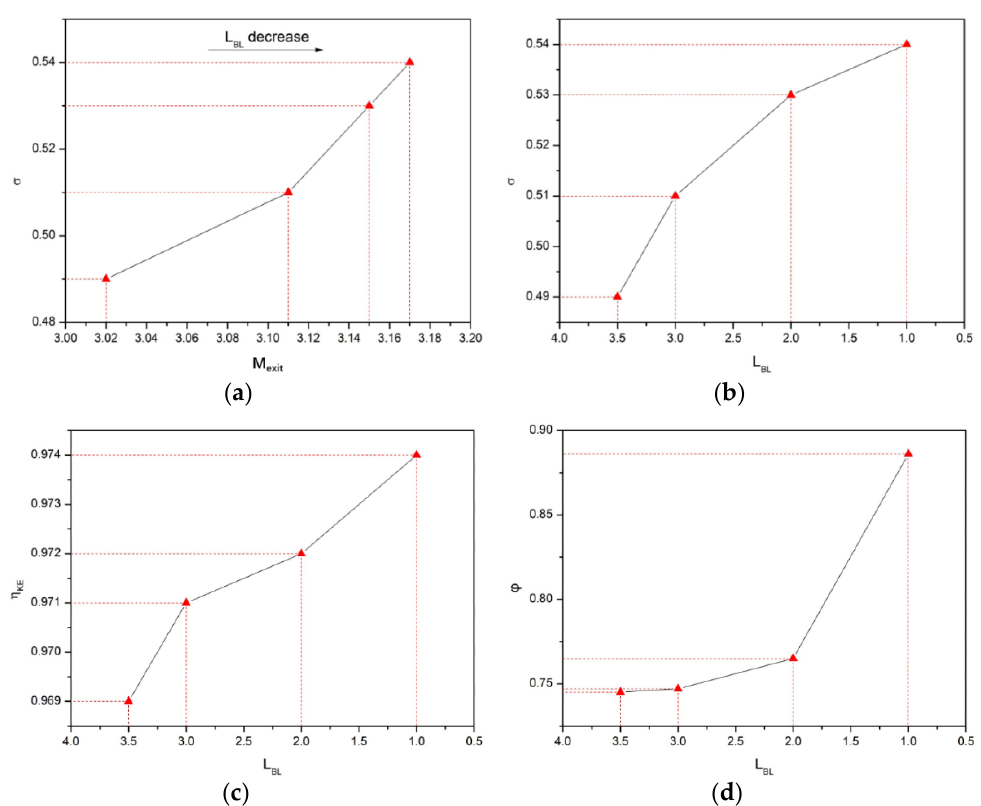
Figure 16. Aerodynamic characteristics of inlet exit under different boundary layer thicknesses (unit of L BL : m). ( a ) σ‐ M exit distribution; ( b ) σ‐ L BL distribution; ( c ) η KE ‐ L BL distribution; ( d ) φ‐ L BL distribution.